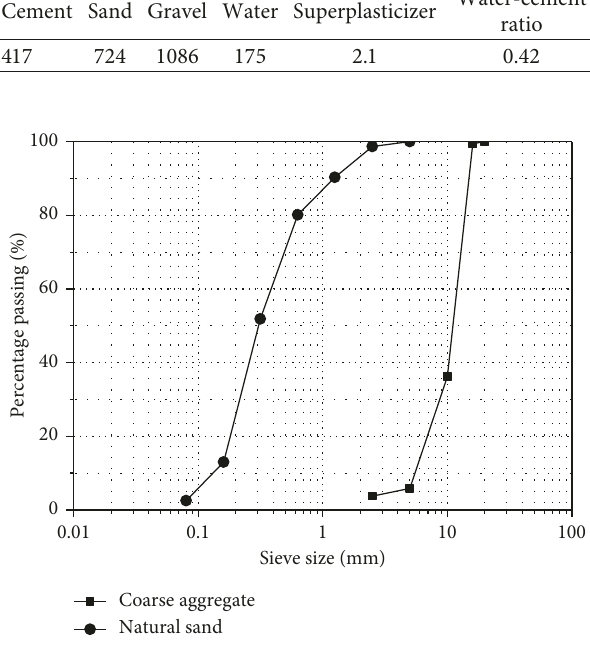
Figure 1: Grading curves for fine and coarse aggregates.